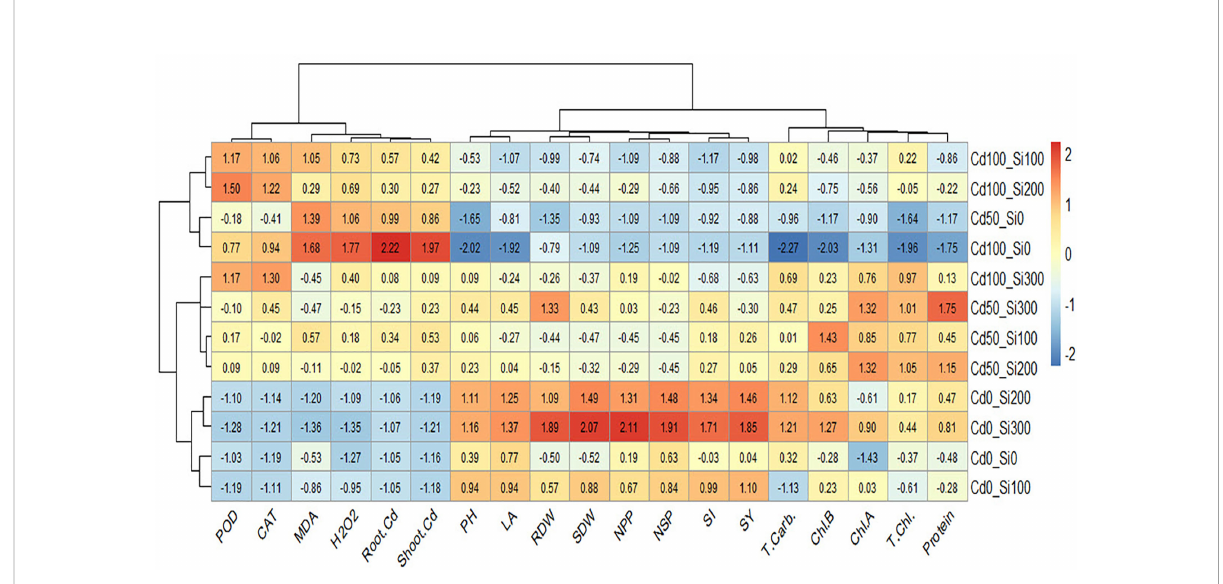
FIGURE 10 Heatmap showing the relationship between the studied traits and the